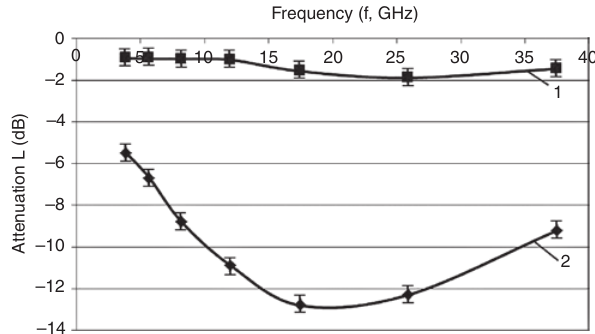
Figure 1: Dependence of EMF attenuation on the EMR frequency for 50- μ m thick carbon layer deposited on the glass. 1, reflection losses; 2, absorption losses.